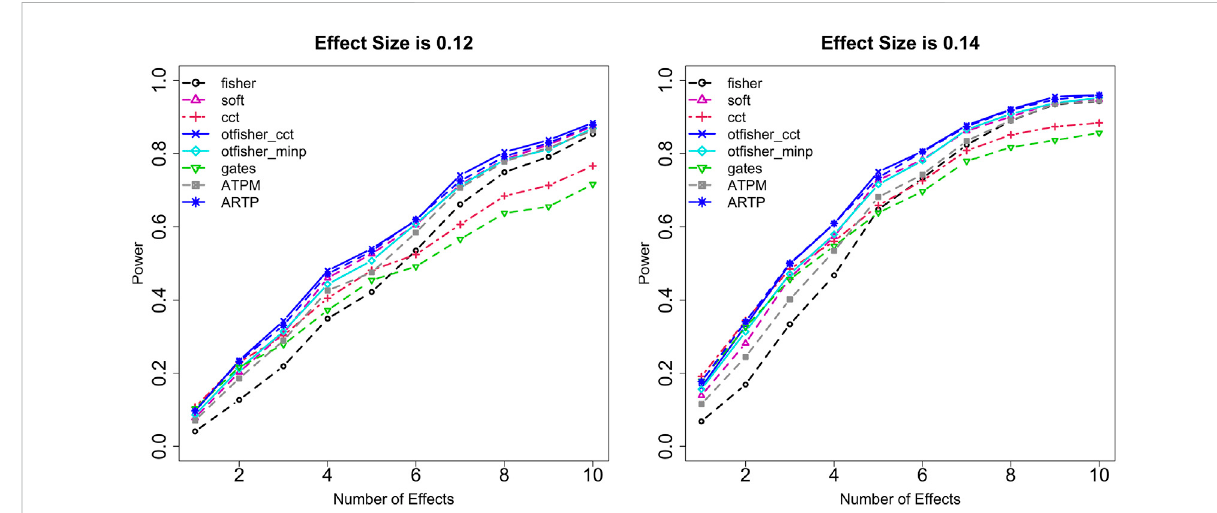
FIGURE 2 Powercomparisonamongthedata-adaptivetests.Quantitativetraitsfromrarevariants. α =0.01.Fixingtheeffectsizetobe0.12(leftpanel)and 0.14 (right). X -axis: The number of causal SNPs. Testing methods: fi sher: Fisher ’ s method; soft: soft-thresholding TFisher with τ 1 = τ 2 = 0.05; cct: Cauchy combination test; ot fi sher_minp: oTFisher in Eq. 2; ot fi sher_cct: oTFisher in Eq. 3; gates: extended Simes procedure; ATPM: adaptive TPM; ARTP: adaptive